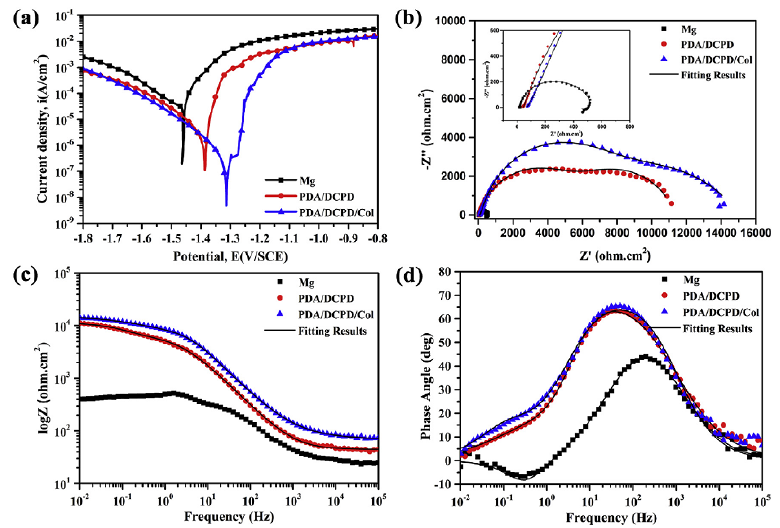
Figure 8. Electrochemical corrosion behavior of different samples: ( a ) Polarization curves; ( b ) Nyquist plots; ( c ) Bode plots of log |Z| and ( d ) Bode plot of phase angle. Reprinted with permission from [84]; Copyright 2020 Elsevier.